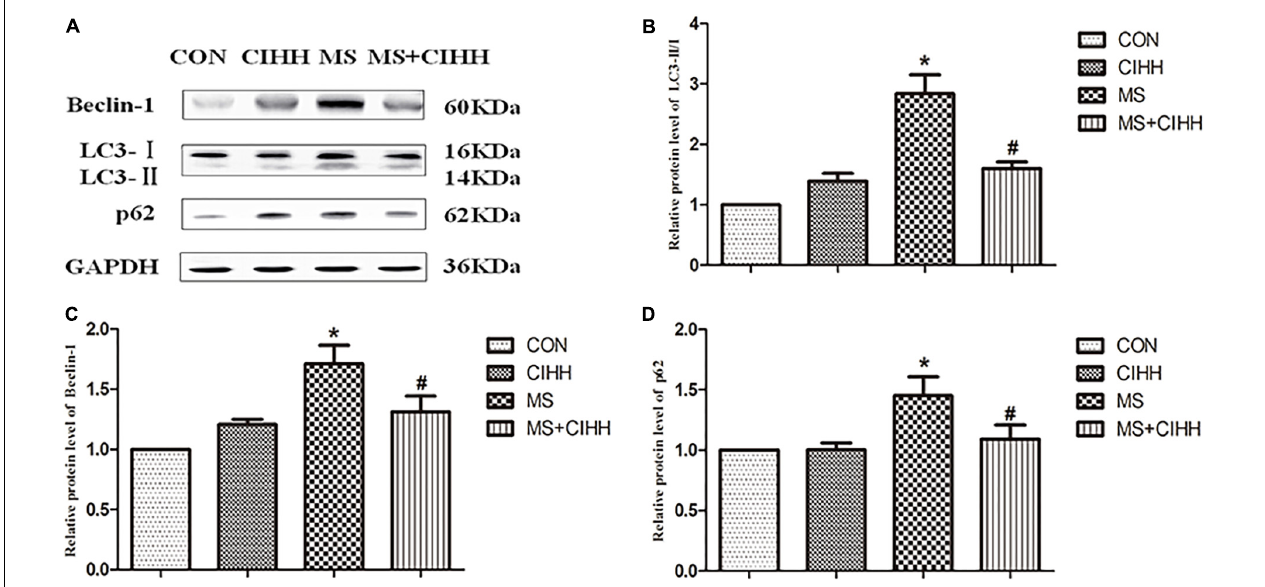
FIGURE 6 | Effect of CIHH on the expression of autophagy-related proteins in rat livers. (A) Original recording of Western blotting. (B) Quantification of protein levels of LC3-II/I. (C) Quantification of protein levels of Beclin-1. (D) Quantification of protein levels of p62. CON: control group, CIHH: CIHH group, MS: metabolic syndrome group, MS + CIHH: MS + CIHH group. All data were expressed as mean ± SD; n = 4 for each group. * P < 0.05 vs. CON, # P < 0.05 vs. MS.